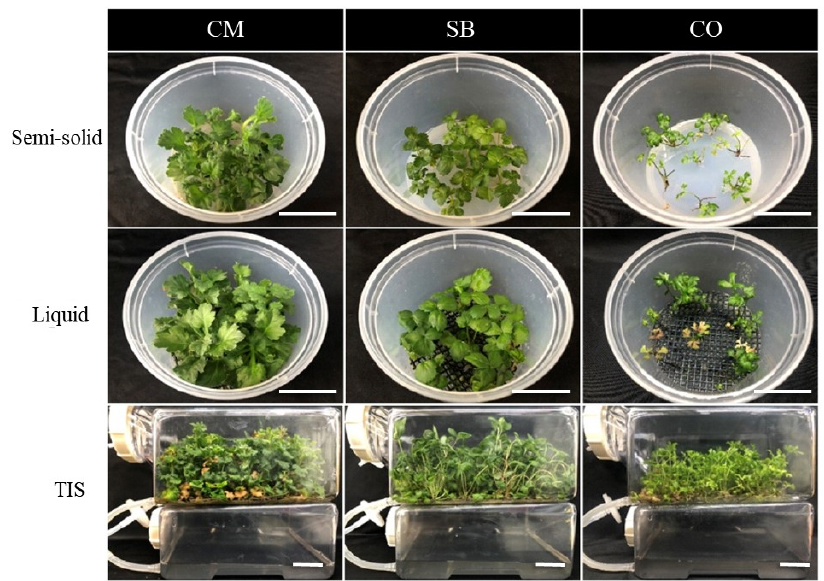
Figure 2. Chrysanthemum (CM), strawberry (SB), and Cnidium officinale (CO) plants after 4 weeks in semi-solid liquid and TIS cultures. Scale bars = 5 cm.